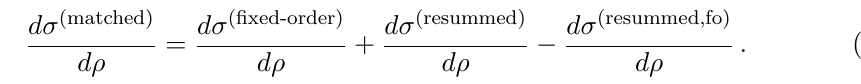
Figure 3 . Plots of the fractional di(cid:11)erence (cid:1) ( n ) between the complete cross section and the leading-power expansion in the (cid:26) (cid:28) z cut (cid:28) 1 limit at O ( (cid:11) s ) ( n = 0, upper left), O ( (cid:11) 2 upper right), and O ( (cid:11) 3 ) ( n = 2, bottom). Values of z cut = 0 : 04 ; 0 : 06 ; 0 : 08 ; 0 : 1 are shown. s As (cid:26) ! 0, the (cid:12)nite z corrections at O ( (cid:11) 3 ) are signi(cid:12)cantly smaller than the expected cut s z cut